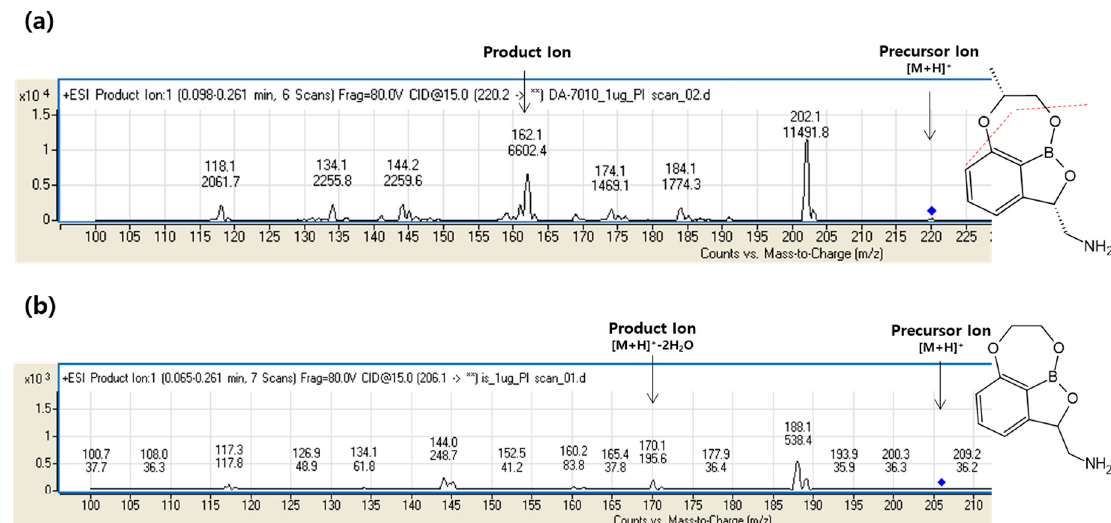
Figure 2. Product ion mass spectra of ( a ) DA-7010 and ( b ) the IS.